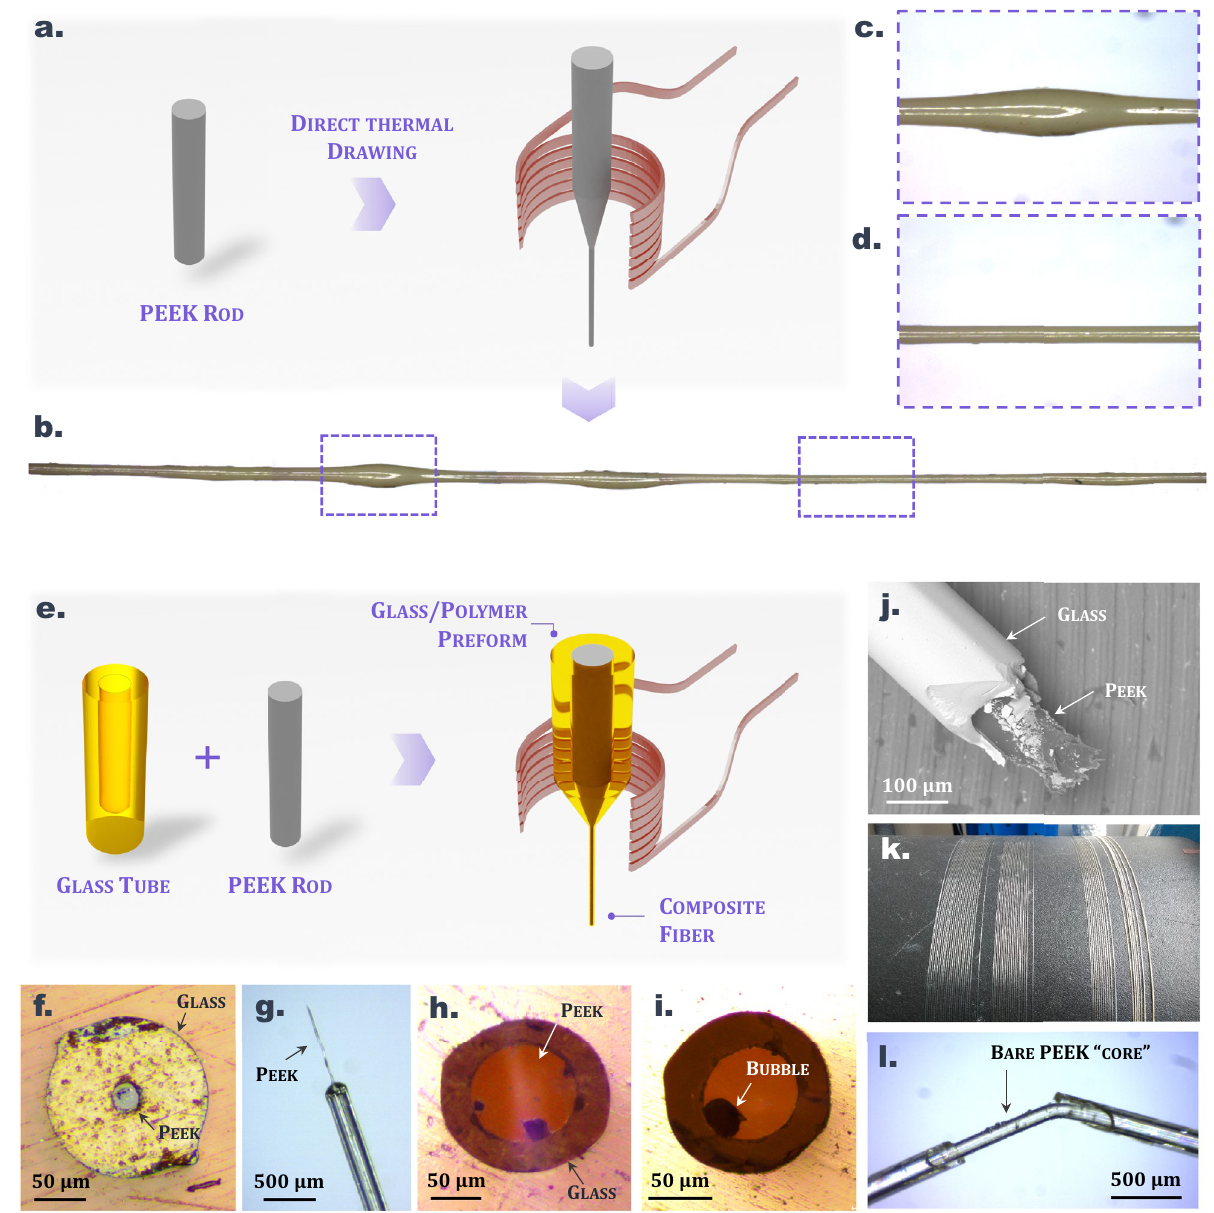
Figure 4. ( a ) Description of the fabrication process of a single-material PEEK fiber through the conventional drawing process (image created using blender software version 2.92.0, www. blend er. org/). ( b ) Picture of a ≈5 cm long single-material PEEK fiber with a non-constant diameter. Portions of fiber with ( c ) or without ( d ) diameter irregularities (beadings). ( e ) Description of the fabrication process of a composite Tellurite/PEEK fiber through the molten core method (image created using blender software version 2.92.0, www. blend er. org/). ( f ) and ( h ) cross-sectional view of the Tellurite/PEEK composite fibers with various core/cladding ratios. ( i ) Fiber with a bubble defect. ( g ) Longitudinal view of the composite fiber with the central PEEK core poking out at the fiber tip. ( j ) SEM image (× 205) of a roughly cut Tellurite/PEEK fiber. ( k ) ≈60 m of tellurite/PEEK fiber stored on a spool. ( l ) Picture of a fractured segment of the composite